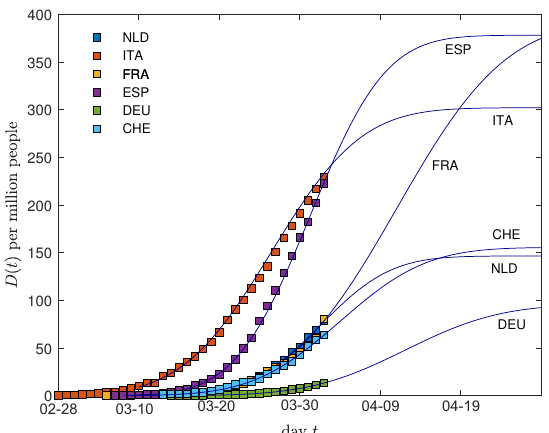
Figure 5. Measured cumulative number of deaths per one million inhabitants (symbols), compared with the GM predictions (A7) for selected fits of Table 1. The cumulative number of fatalities determining the height of the future plateau is given by the product of width w d and d max , times Next, we estimate the number of required respiratory machines per date for the Covid-19